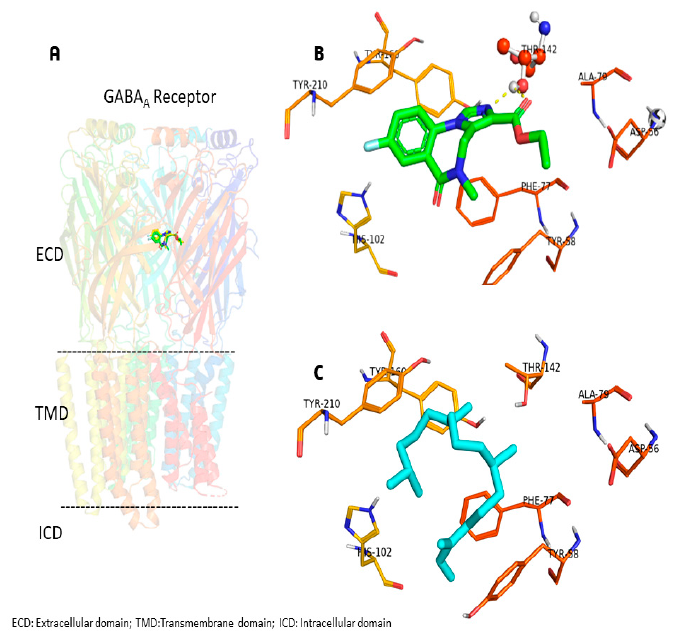
Figure 5. ( A ) Heteropentameric GABA A receptor (PDB id: 6D6T) displayed in cartoon representation with competitive antagonist flumazenil (green color). ( B ) Flumazenil interacting with the binding pocket with hydrophobic residues, H-bond is shown in dashed line, and Thr142 is represented in ball and stick. ( C ) Neophytadiene (cyan color) is surrounded by hydrophobic residues in the pocket.